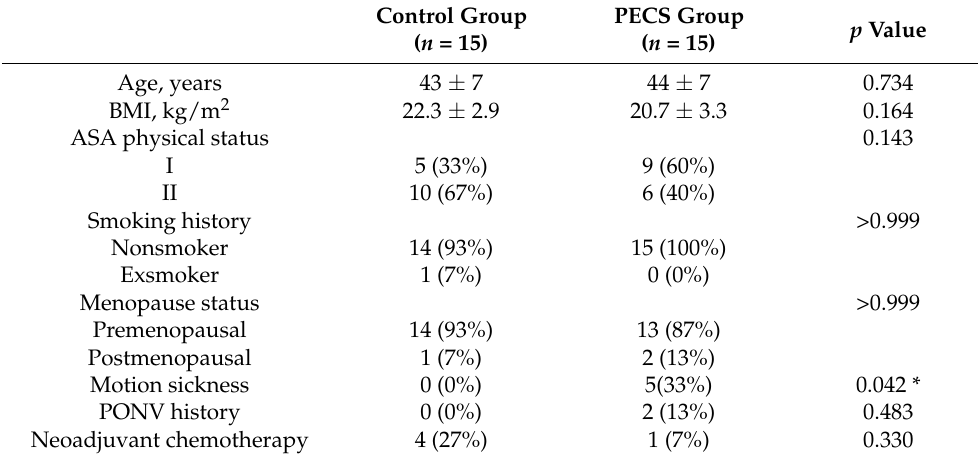
Table 1. Patient characteristics.